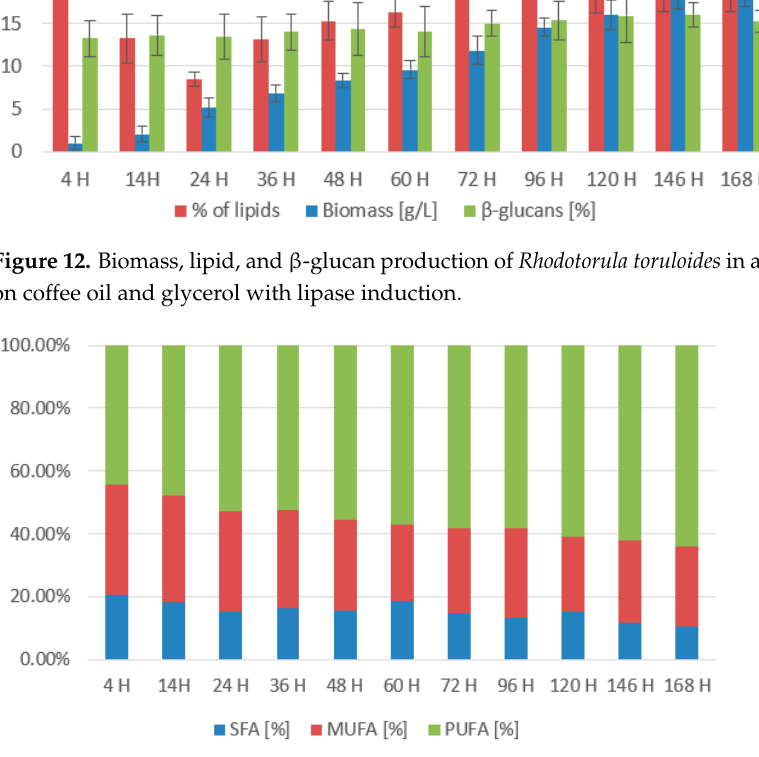
Figure 13. Fatty acid production of Rhodotorula toruloides in a bioreactor cultivation on coffee oil and glycerol with lipase induction. Table 8. HPLC analysis of bioreactor cultivation of Rhodotorula toruloides cultivated on coffee oil and glycerol with lipase induction. Productions are listed in mg/g of cell dry weight.